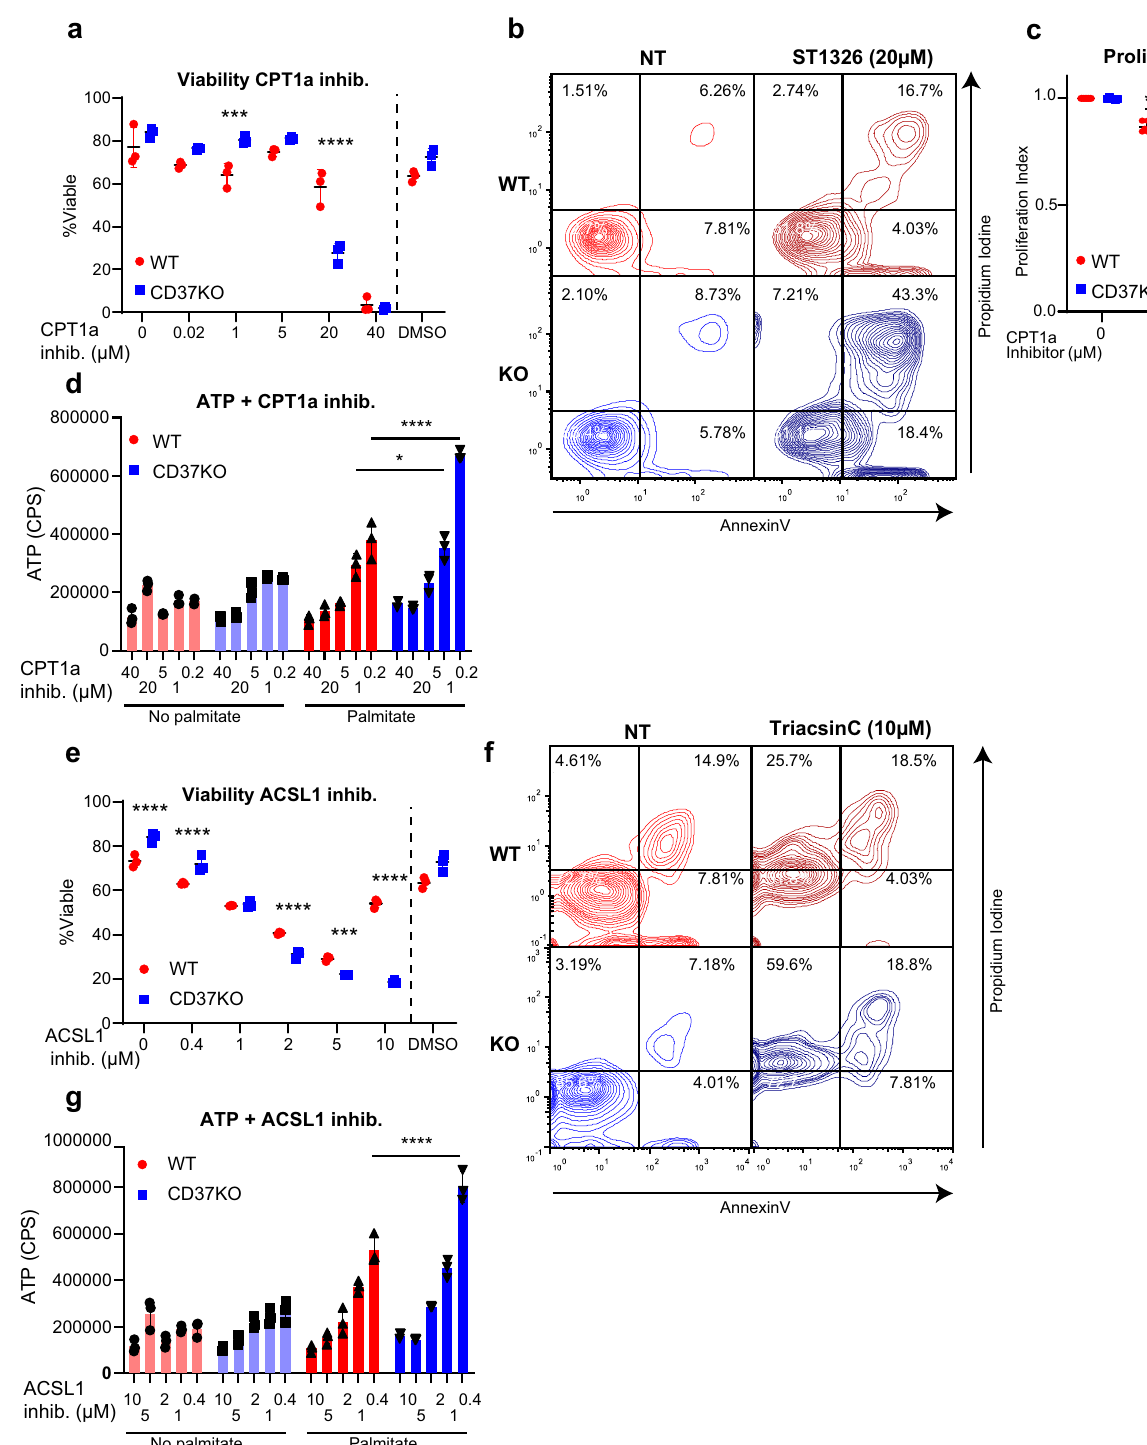
Fig. 6 | CD37KO B-cell lymphomas are dependent on the fatty acid metabolic switch and can be therapeutically targeted using FA inhibitors. Effects of 24h CPT1a inhibition with ST1326 at indicated concentrations on viability ( n =3, 1 µ M; p =0.0031, 20 µ M; p <0.0001), apoptosis, necrosis ( a , b ) proliferation capacity ( n =6,5 µ M; p =0.0003,10 µ M; p =0.0009)( c )andonpalmitate-dependentenergy production by WT and CD37KO lymphoma cells ( n =3, 1 µ M; 0.0297, 0.2 µ M; p <0.0001) (in counts per seconds, CPS) ( d ). Effects of 24h ACSL1 inhibition with TriacsinC at indicated concentrations on viability (0, 0.4, 2, and 10 µ M; p <0.0001,